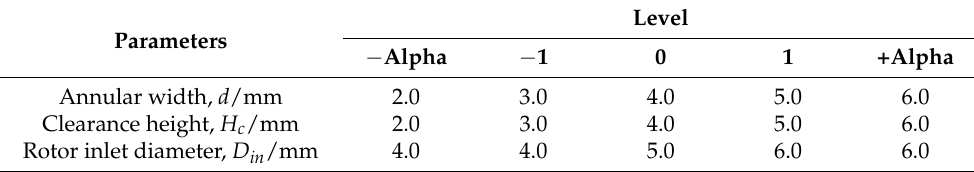
Figure 1. Schematic diagram of annular centrifugal contactor (ACC). Table 1. Central composite design’s (CCD) coding level and value of parameters.